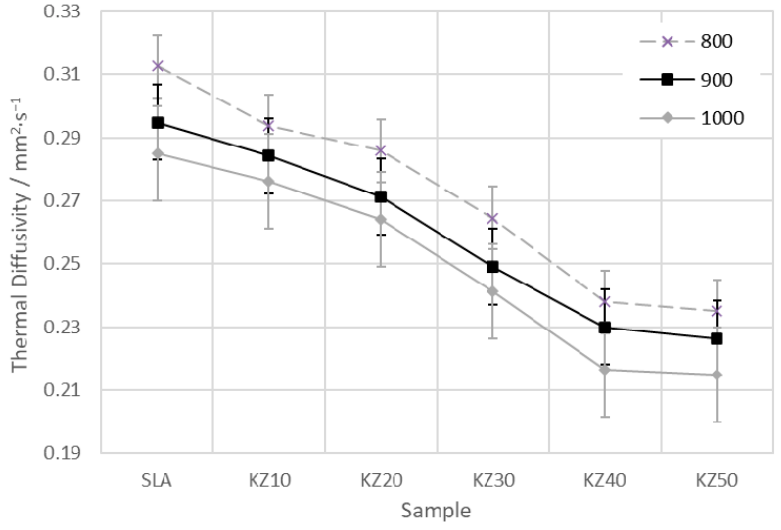
Figure 11. Thermal diffusivity of the studied samples at 800, 900, and 1000 °C.